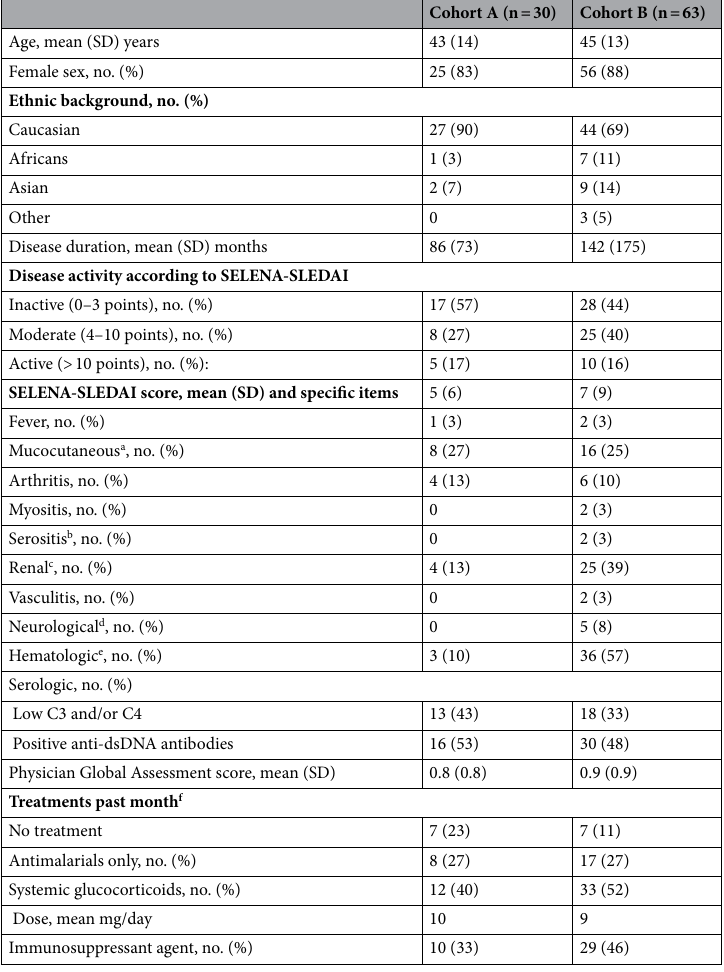
Table 1. Detailed characteristics of SLE patients from cohort A and B. a Included rash, alopecia or mucosal ulcers. b Included pleurisy or pericarditis. c Included urinary casts, hematuria, proteinuria or pyuria. d Included seizure, psychosis, organic brain syndrome, visual disturbance, cranial nerve disorder, lupus headache or cerebro-vascular accident. e Included thrombocytopenia or leukopenia. f Dose of systemic glucocorticoids corresponds to prednisone or equivalent, and immunosuppressant agents included azathioprine, methotrexate, and mycophenolate mofetil used during the last 4